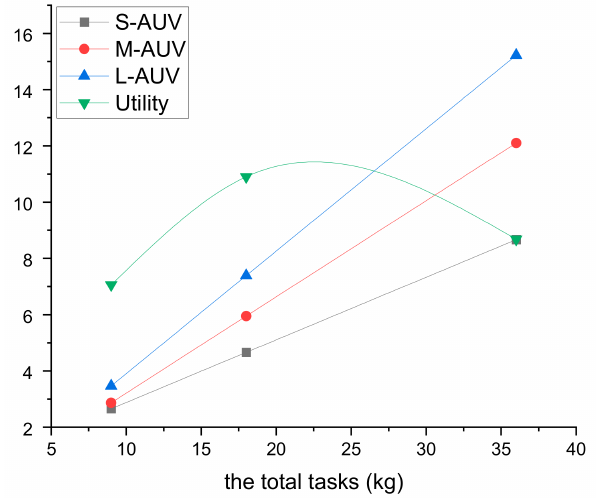
Figure 3. The line chart of the values simulated in the small-scale system under three different w total .